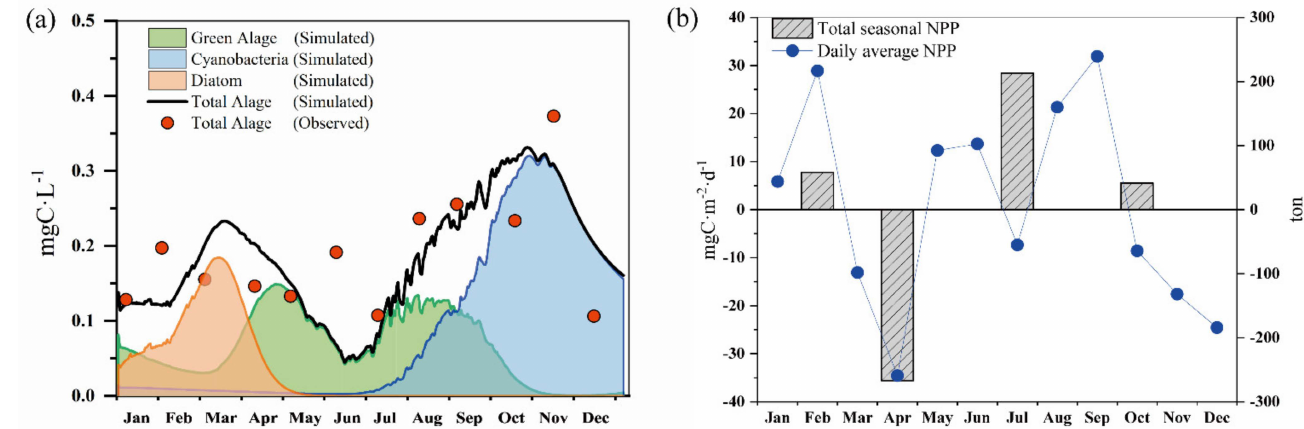
Figure 5. Simulated total biomass of phytoplankton and net primary production in Lake Erhai: ( a ) the simulation of phytoplankton biomass in Lake Erhai; ( b ) phytoplankton net primary production in Lake Erhai in each month and season of 2017. The daily average NPP of every month and total seasonal net primary production (including basal metabolism, grazing and settling, in ton) is represented by a dark blue dot and column,